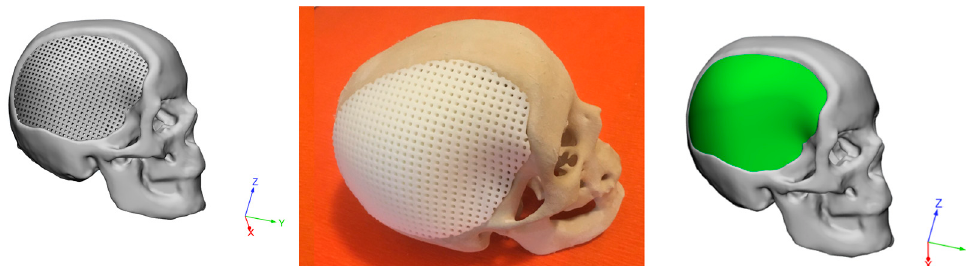
Figure 10. Feasibility of the reported technical solutions: images of virtual ( left ) and physical ( center ) models of skull with 3D additive manufactured PCL porous structure for large cranial defect 3D porous structure; image of virtual model of skull with 3D hybrid device (3D PCL porous structure infiltrated with PMMA/Cu-TCP 97.5/2.5 bone cement) for large cranial defect ( right ).